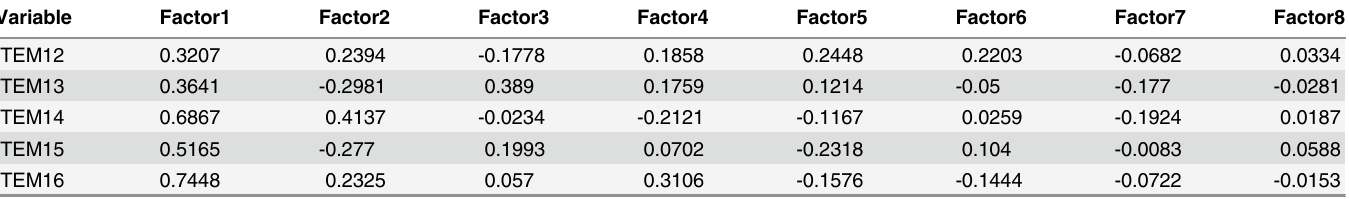
Table 5. Factor loadings of the domain B in the Osteoporosis Prevention and Awareness Tool (OPAAT) using exploratory factor analysis (EFA).